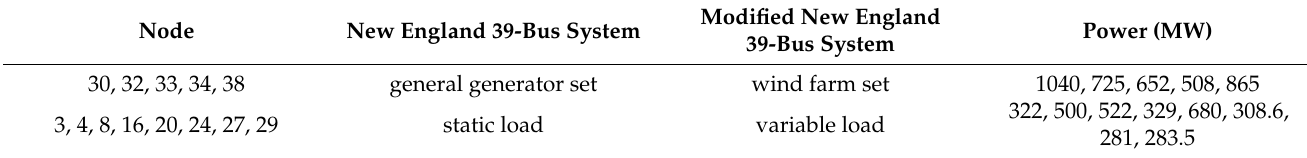
Table 11. Changes of generator set and load in modified New England 39-bus system.